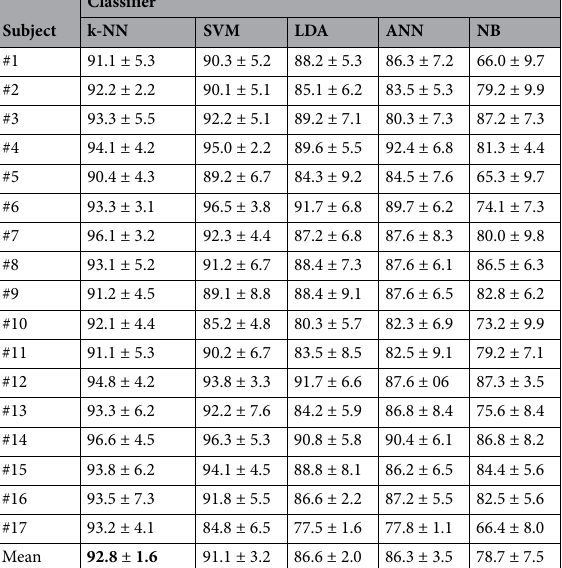
Table 4. Within-subject accuracy of the proposed solution based on the 12 bandpass Filter Bank and Common Spatial Pattern at varying the classifier. The best performance mean value is highlighted in bold.